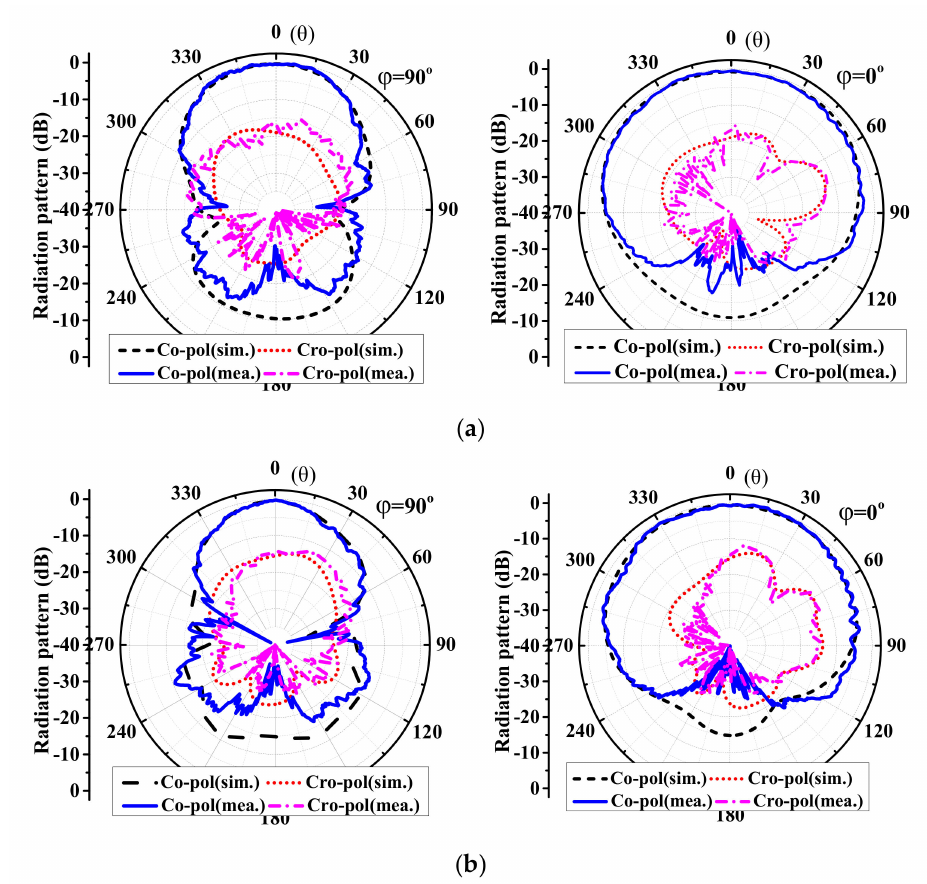
Figure 11. Radiation patterns for the proposed antenna in the yoz-plane (E-plane) and the xoz-plane (H-plane). ( a ) At 35 GHz. ( b ) At 45